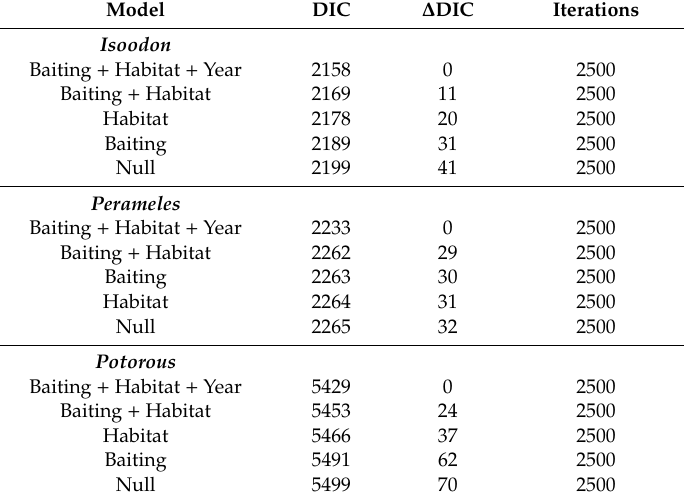
Table 7. Model scenarios used to estimate detection probability of Isoodon, Perameles and Potorous in Ben Boyd and